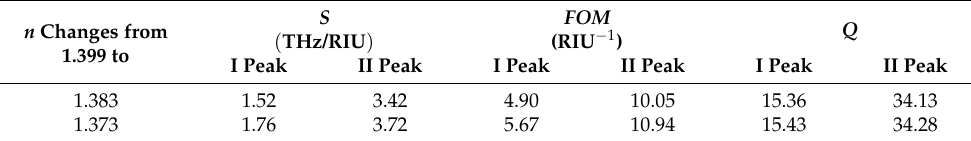
Table 3. Proposed sensor’s sensing parameters for malaria diagnosis.